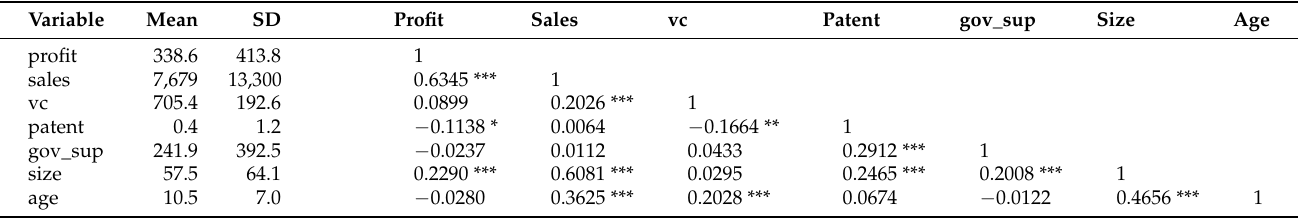
Table 3. Descriptive statistics and correlations between